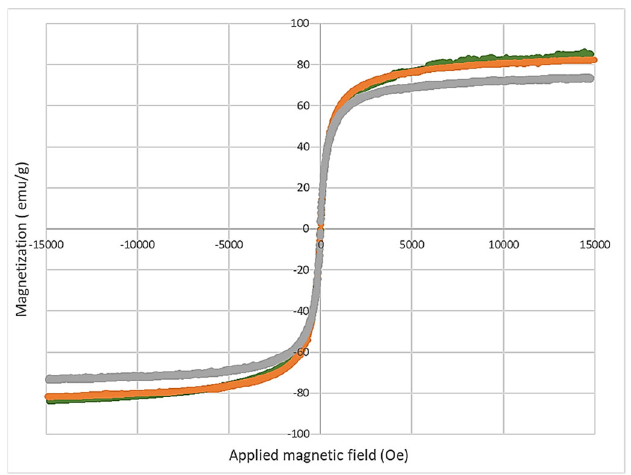
Figure 2. Magnetization loop of bare Fe 3 O 4 (green), citrate ‐ 80C ‐ Fe 3 O 4 (orange), and NH 2 ‐ Fe 3 O 4 (grey).